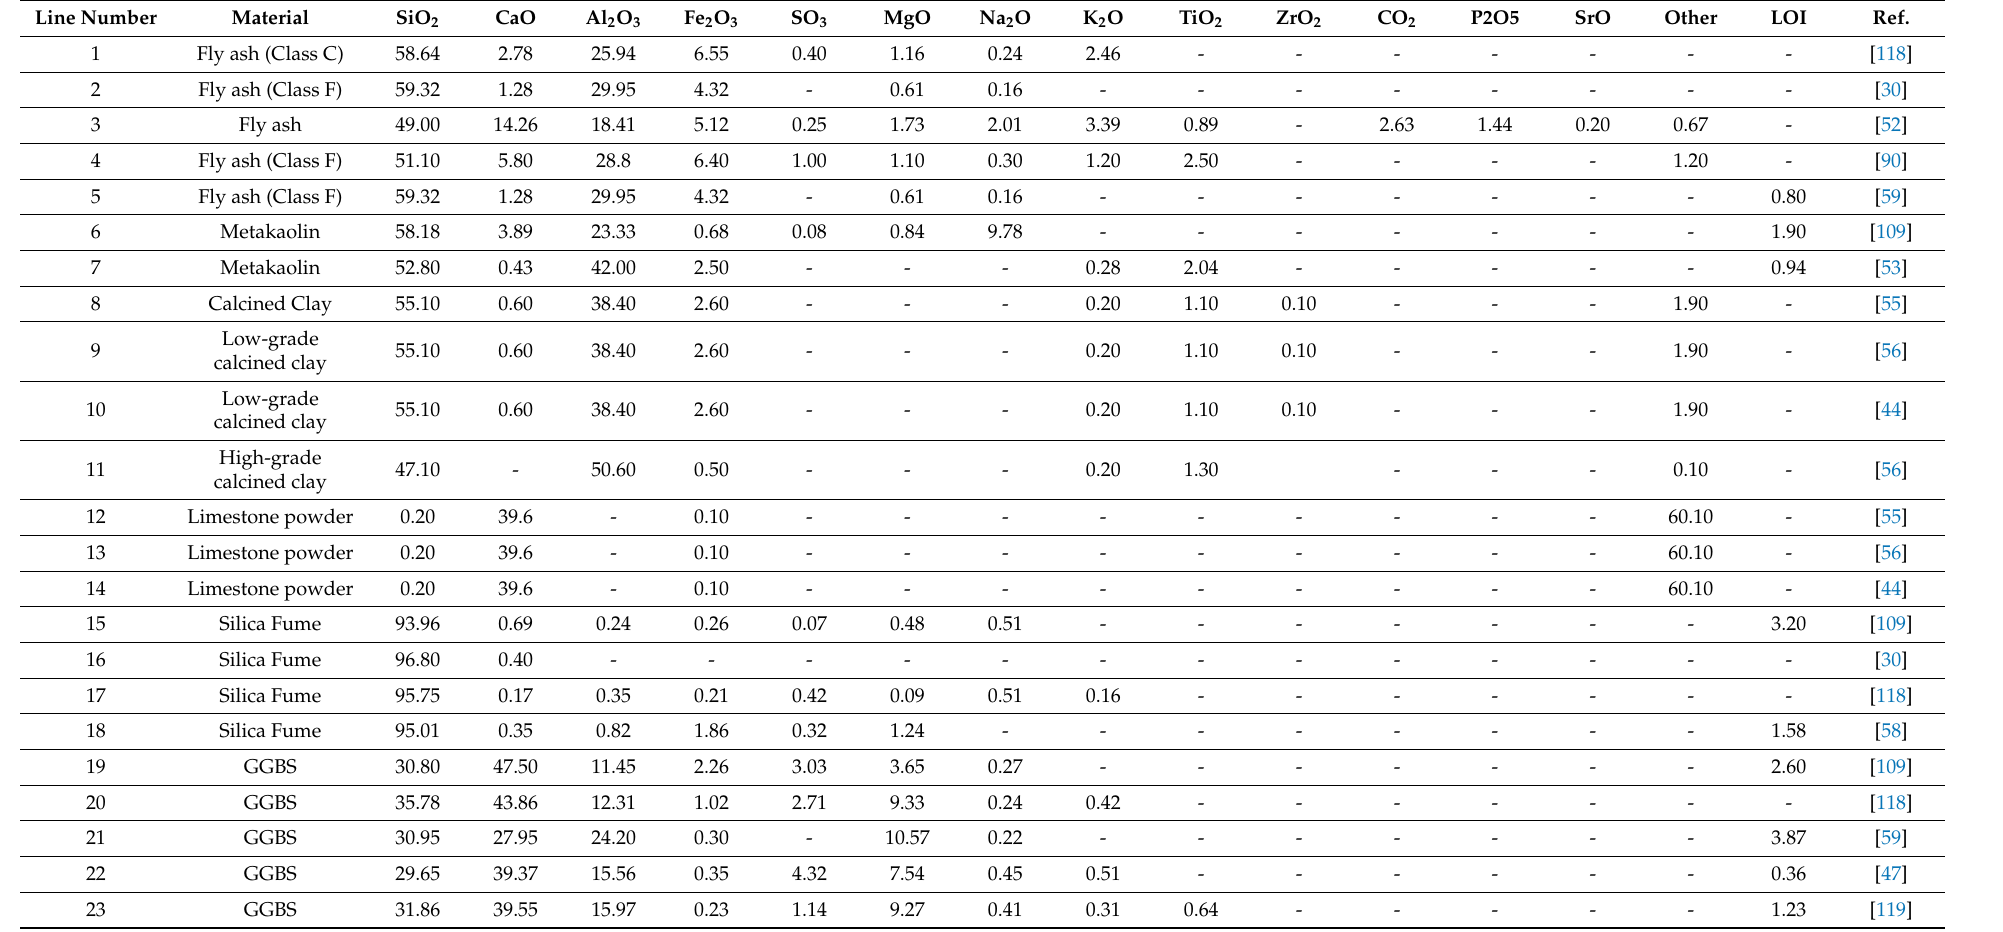
Table 3. Chemical composition of standard SCM used in 3DPCC